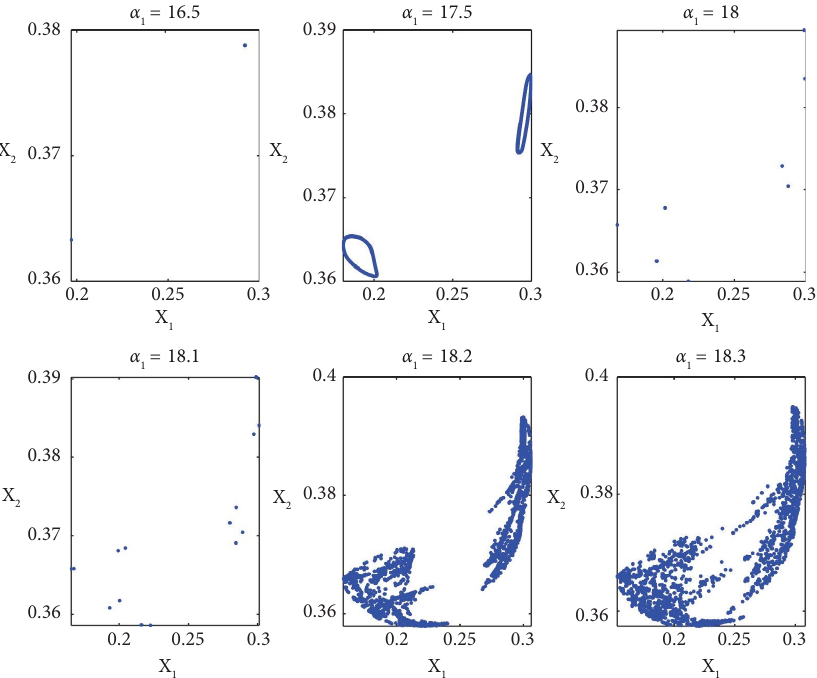
Figure 5: Te phase diagram of the discrete dynamic system (8) under diferent adjustment speeds of R&D investment